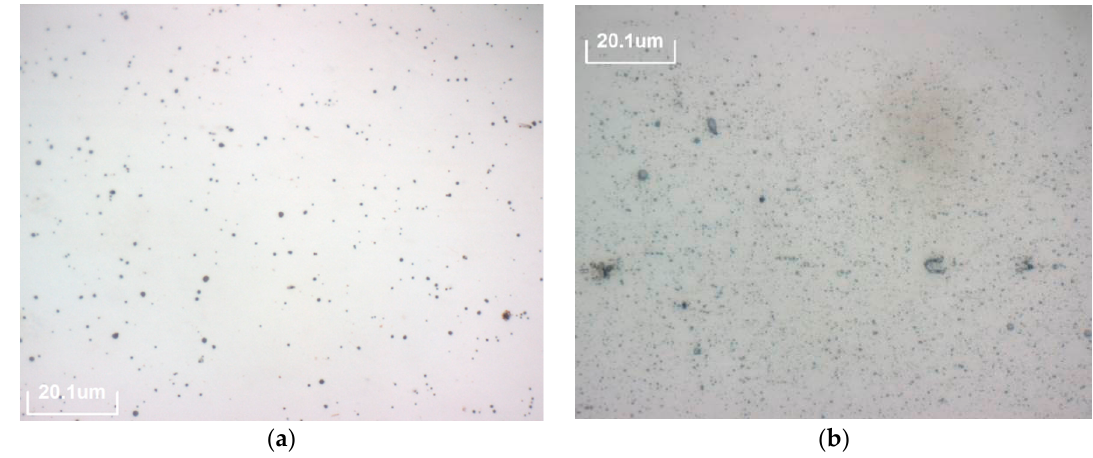
Figure 4. Microscopic images of degradation due to micropitting corrosion in material A ( a ) and C ( b ) after 12 months in Almería.